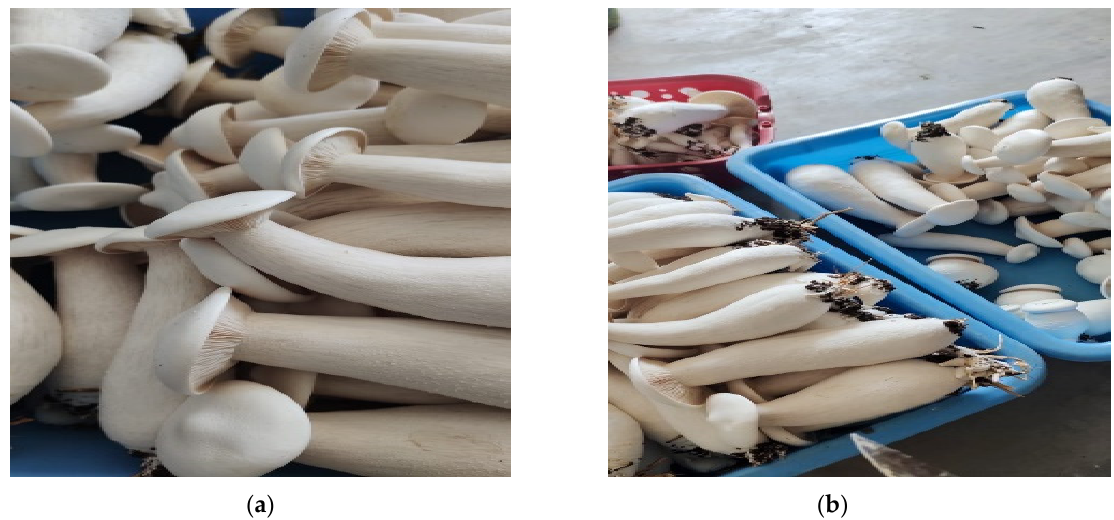
Figure 1. ( a , b ) The fruiting body of Calocybe indica collected from a farm in Chennai, Tamilnadu,